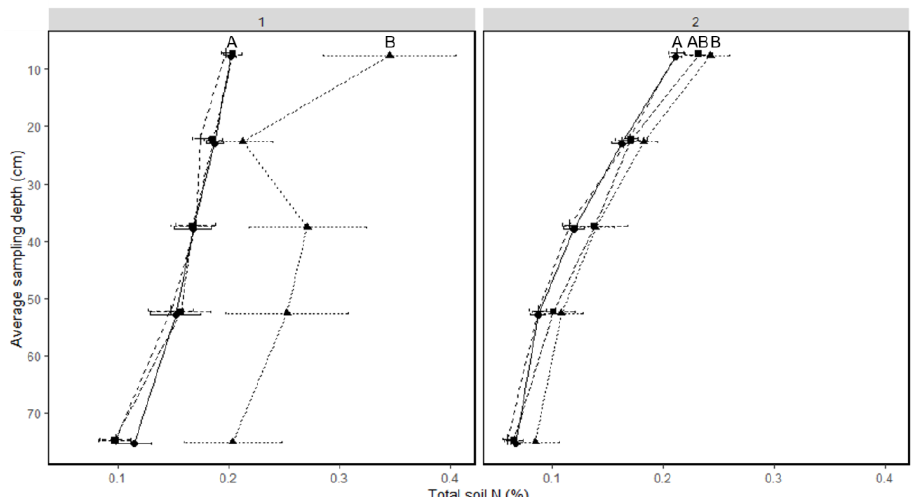
Figure 4. Soil total percent nitrogen by depth and sampling time in 1- and 2-year-old intermediate wheatgrass: 1 = 1-year-old field; 2 = 2-year-old IWG stand. Within a stand, soil N lines with the same or no upper-case letter are statistically similar as per Tukey’s HSD ( p = 0.05). Sampling depth indicated on Y axis is the center of the depth increment sampled. Sampling times with the same upper-case letter are statistically similar as per Tukey’s HSD ( p = 0.05). Crosses with long dashed line = spring regrowth, circles with solid line = anthesis, squares with short dashed line = maturity, triangles with dotted line = fall regrowth.